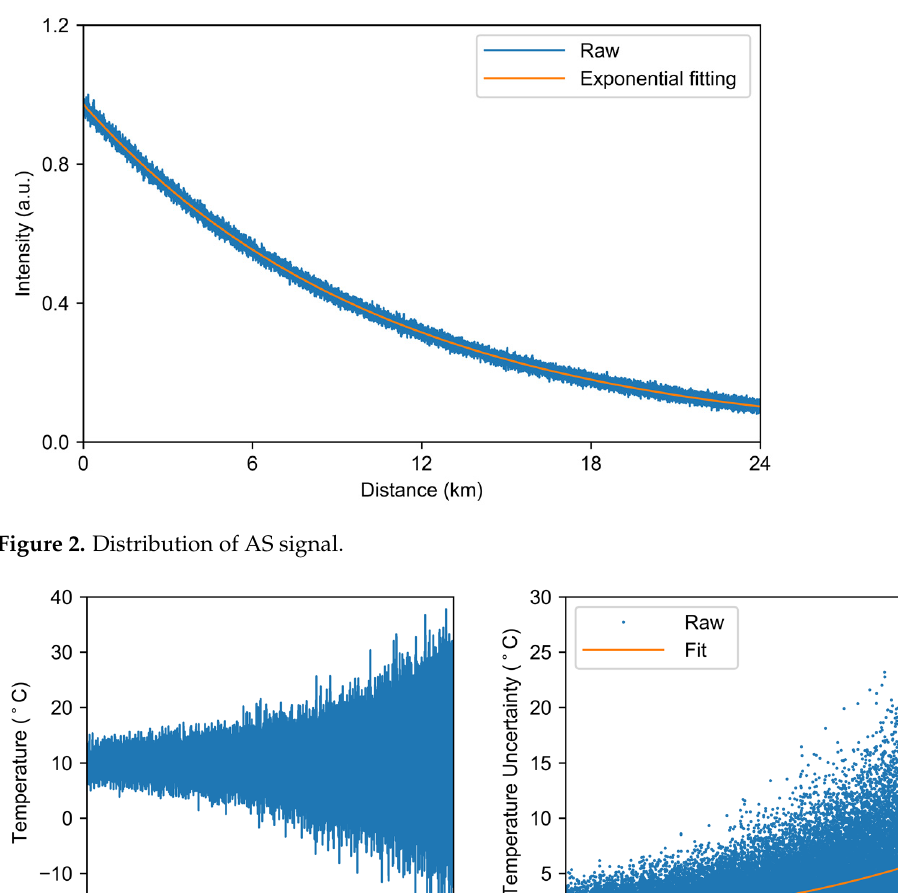
Figure 2. Distribution of AS signal.